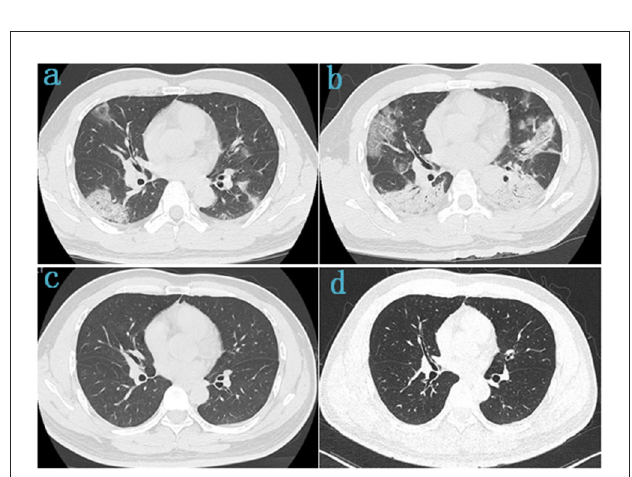
FIGURE4 Chest CT of a 42-year-old male survivor of COVID-19 Delta variant. (a) On admission, baseline scan shows multiple bilateral